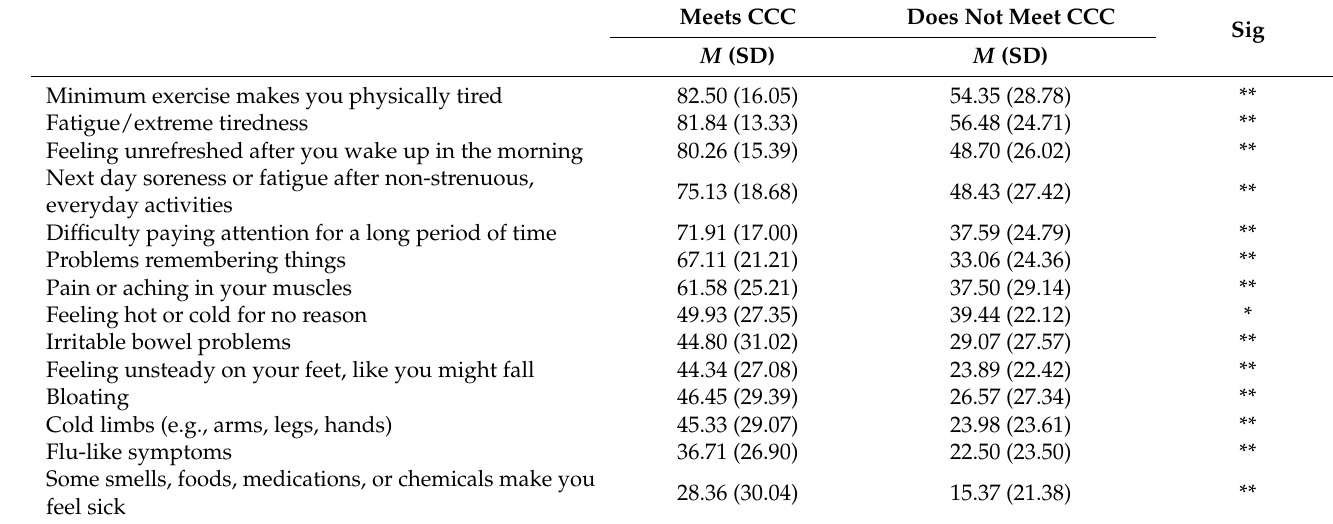
Table 3. DSQ-SF symptom means and standard deviations.